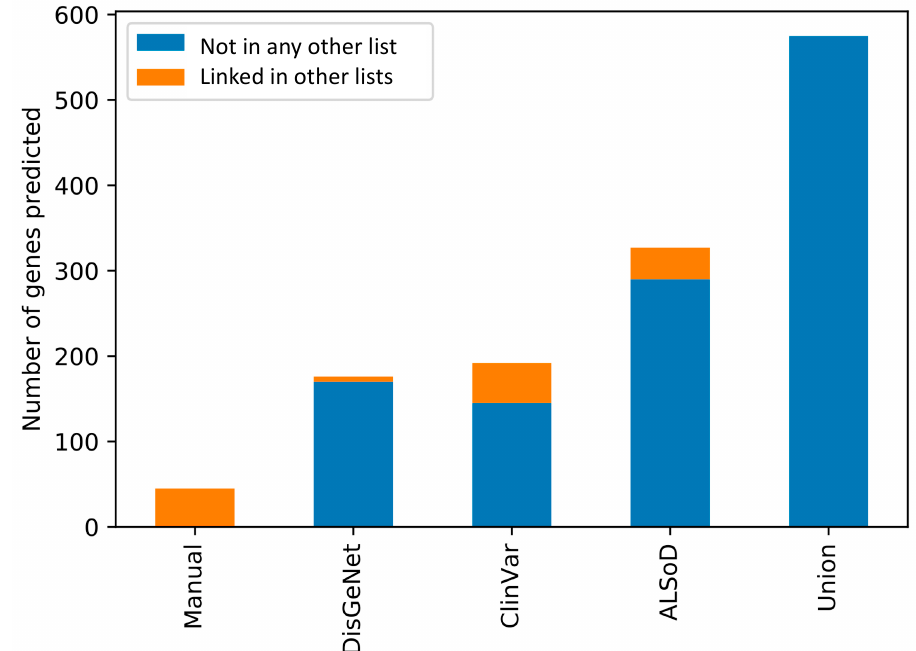
Figure 3. Overlap of the predicted ALS-linked genes from each input list with the other lists of known genes. All the predictions from the Manual list are already contained in at least one other list. By definition, none of the predictions from the union list are in any other list.